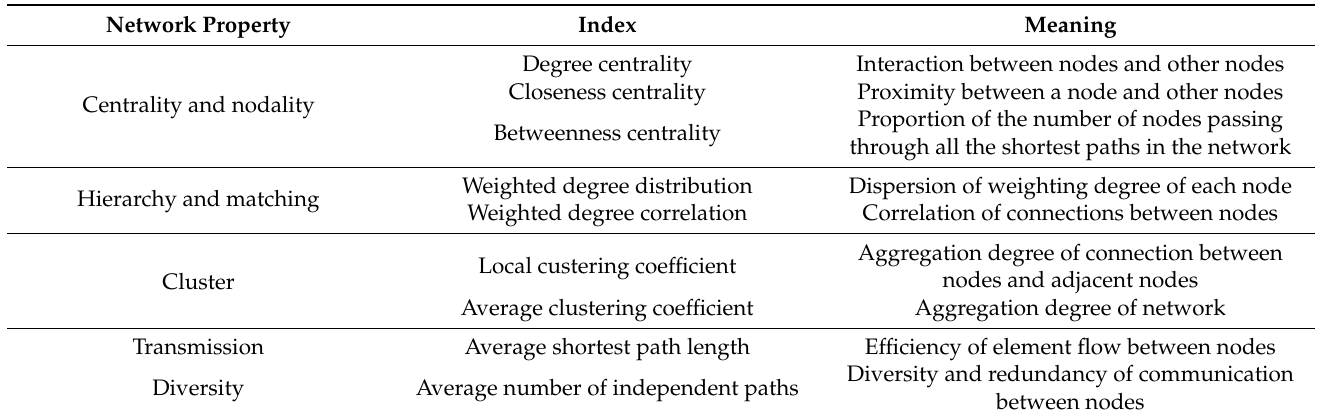
Table 1. Measurement index system for population mobility network